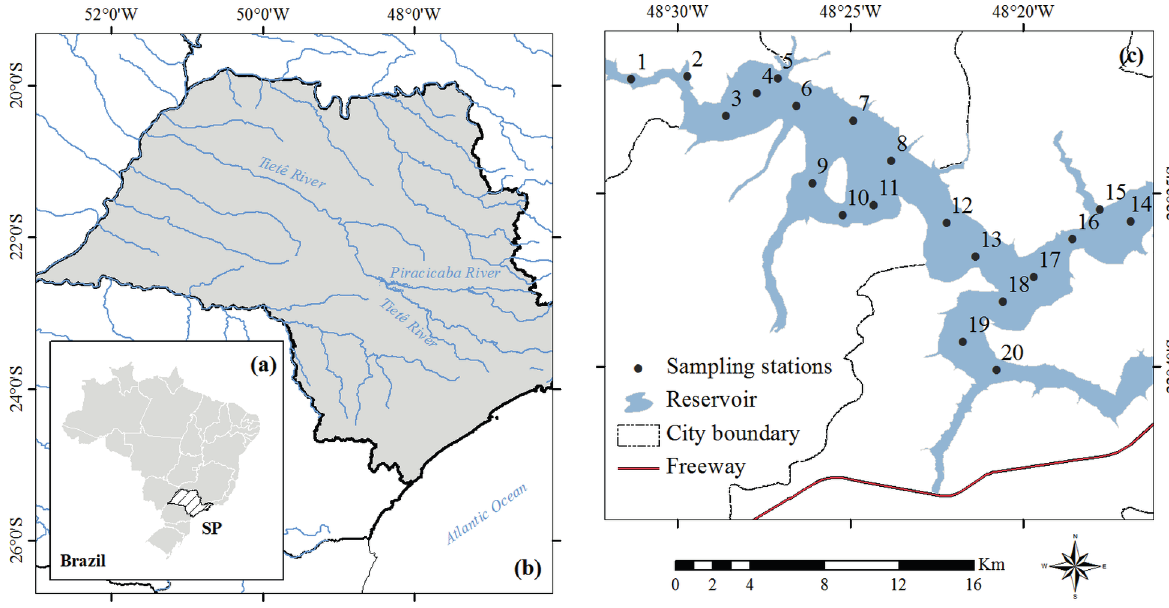
Figure 1 - Study area. ( a ) Location of São Paulo State in Brazil. ( b ) Position of the Piracicaba and Tietê rivers in hydrographical network in São Paulo State. ( c ) Barra Bonita hydroelectric reservoir (BBHR) and distribution of the sampling stations along the